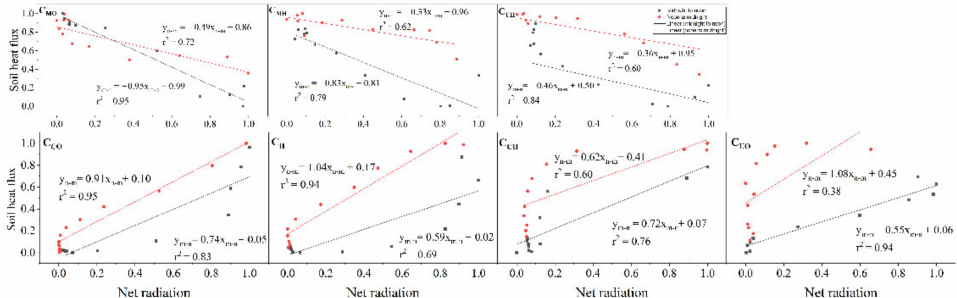
Figure 8. Relationship between normalized net radiation and soil heat flux for different riparian plant communities during sunny days in summer. Each point represents a half-hour average. The relation- ships between normalized net radiation and soil heat flux were statistically significant ( p < 0.05) for all sites. G m − n is G from midnight to noon, and G n − m is G from noon to